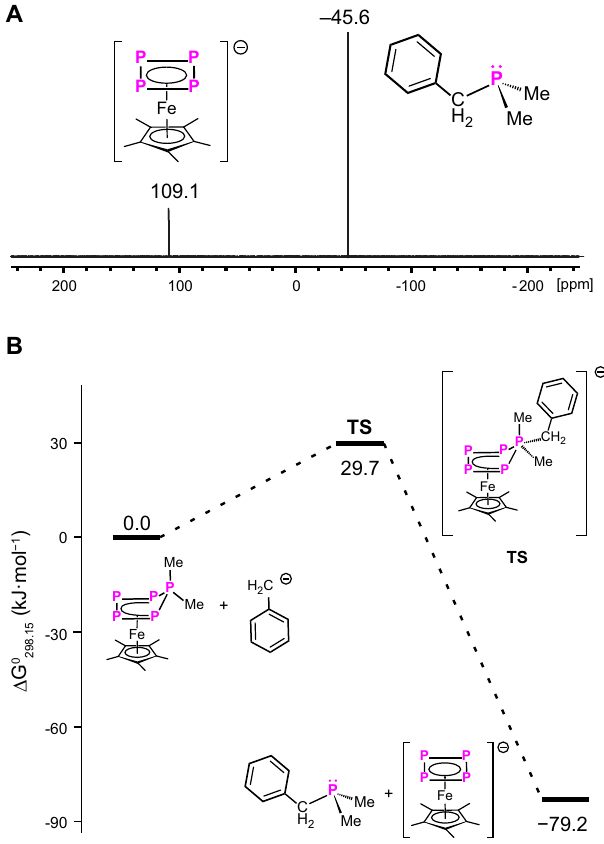
Fig. 5 Identi fi cation of the reaction pathway of phosphine abstraction. A Experimental 31 P{ 1 H} NMR (242.90MHz, THF-d 8 ) spectrum of the crude reaction solution (low-temperature reaction) of 3c with KBnz at 180 K. B Gibbs free energy pro fi le of the reaction of 3c with KBnz, calculated at the